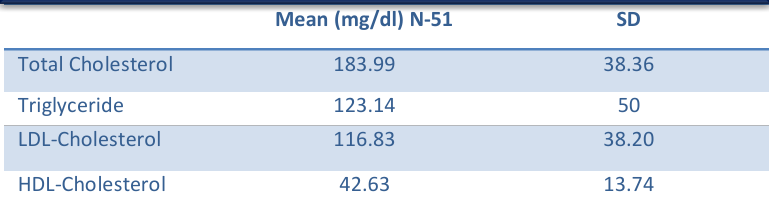
Table 1: Quantitative and Qualitative analysis of lipid profile